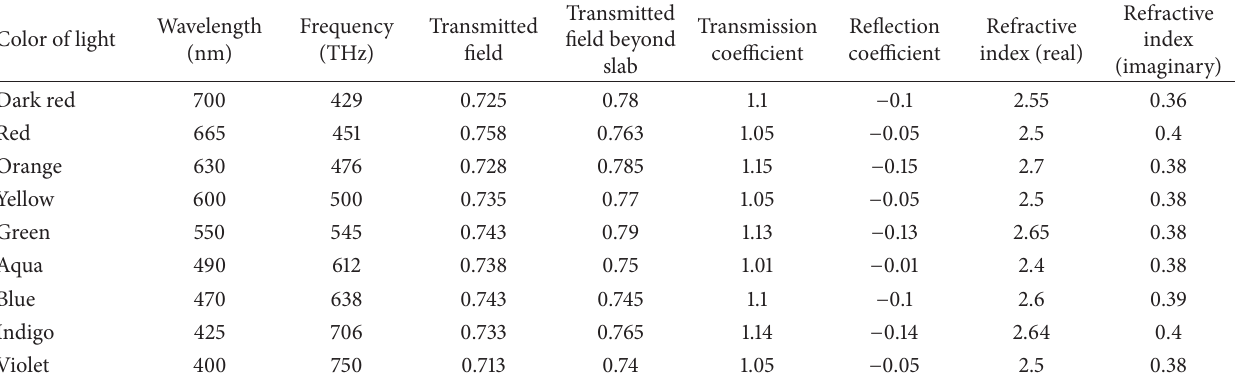
Table 3: Variations in different parameters of an optical cloaking system for a radius ratio of 1.75.